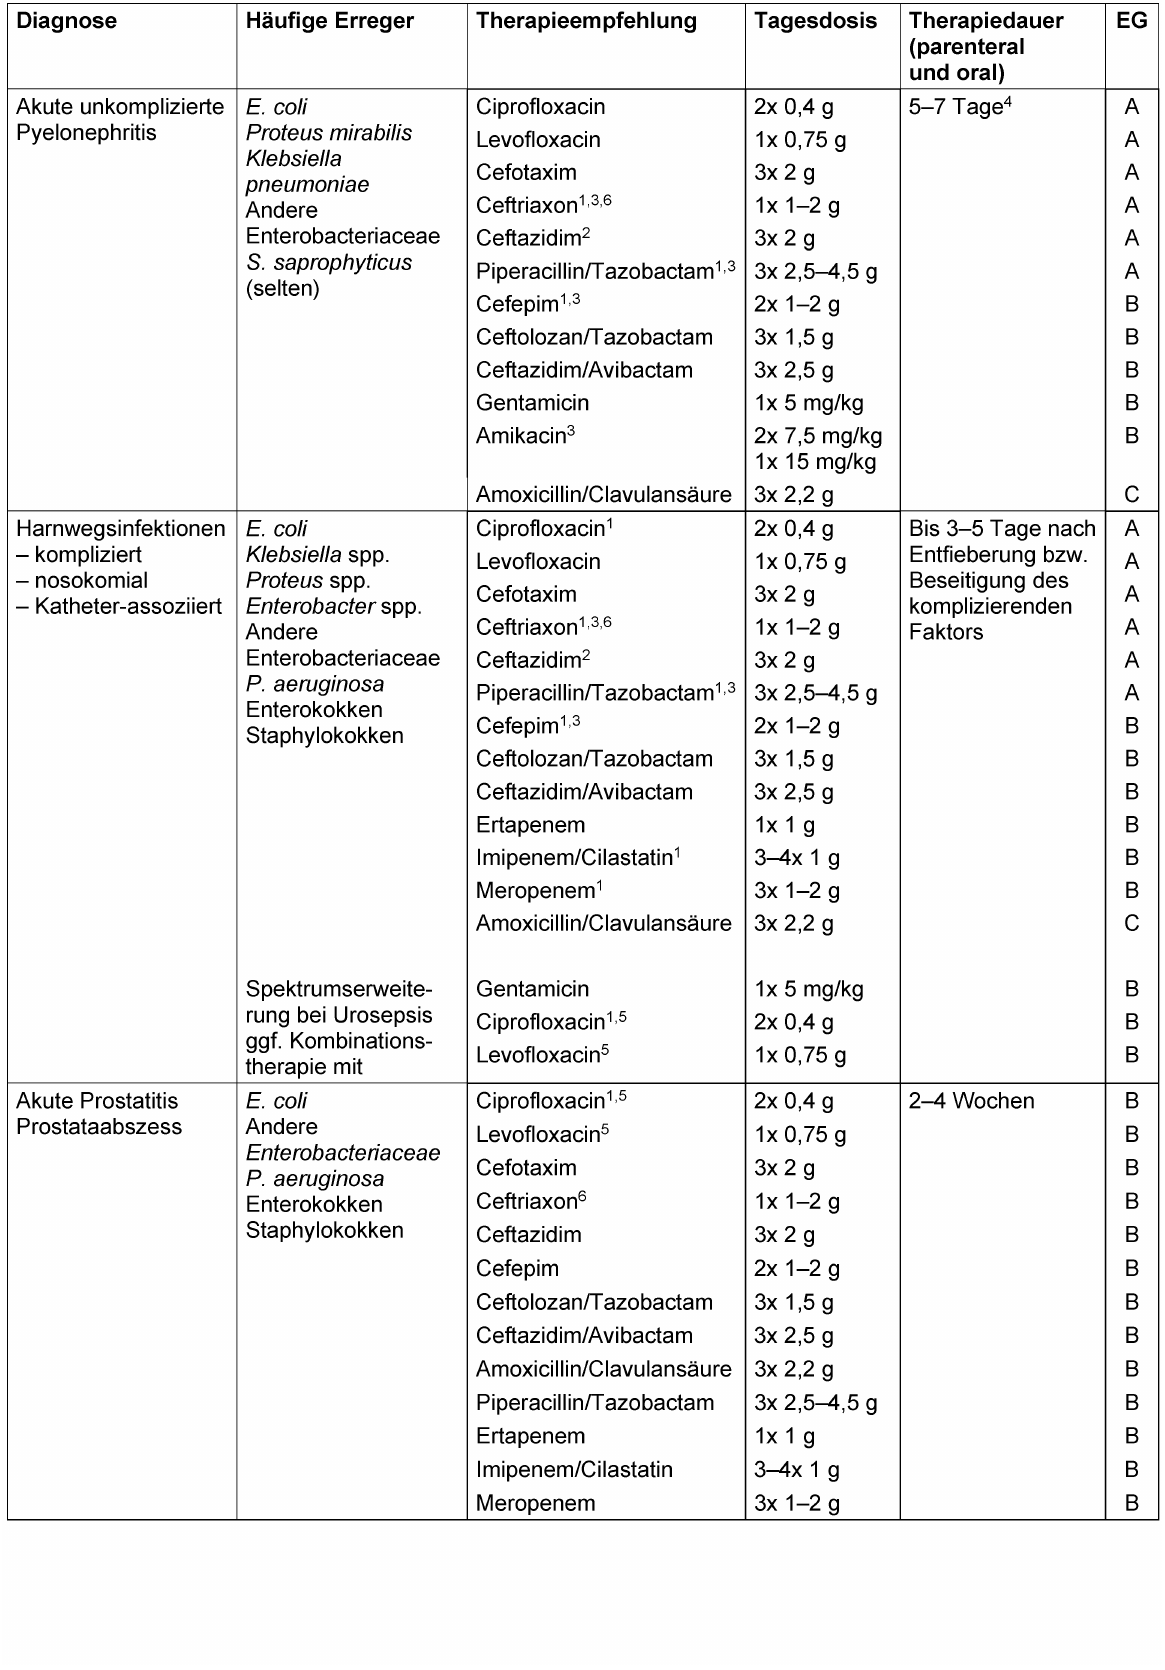
Tabelle 1: Empfehlungen zur empirischen parenteralen Antibiotika-Initialtherapie bei Infektionen der Nieren und